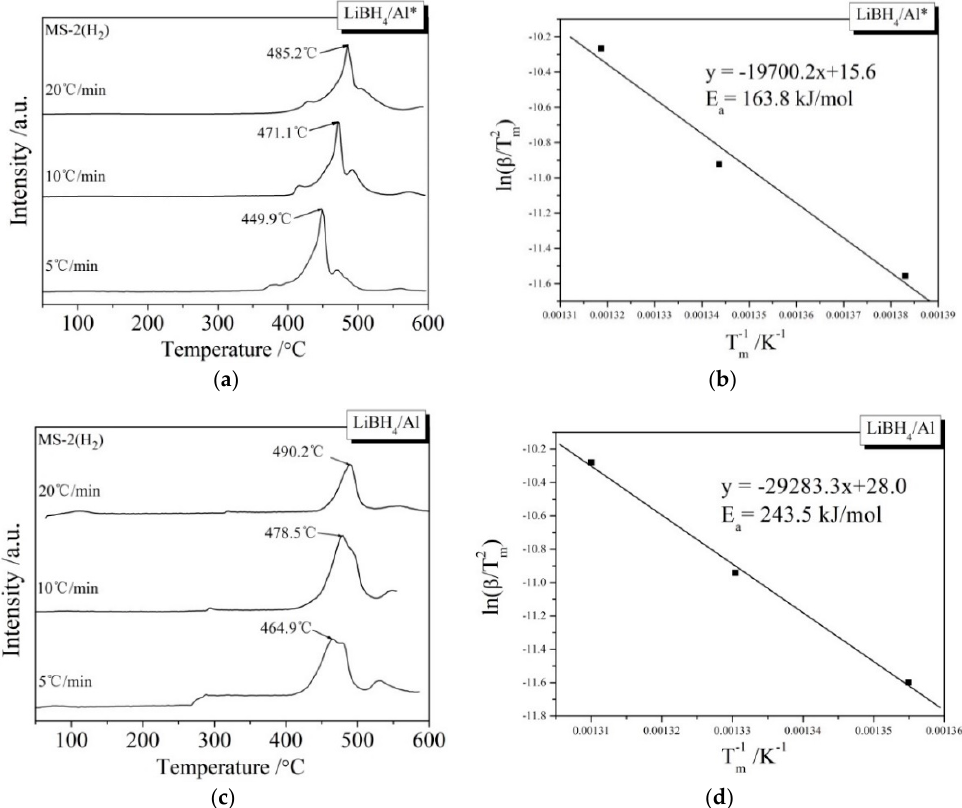
Figure 7. MS curves ( a , c ) of LiBH 4 /Al* and LiBH 4 /Al samples at different heating rates (5, 10, and 20